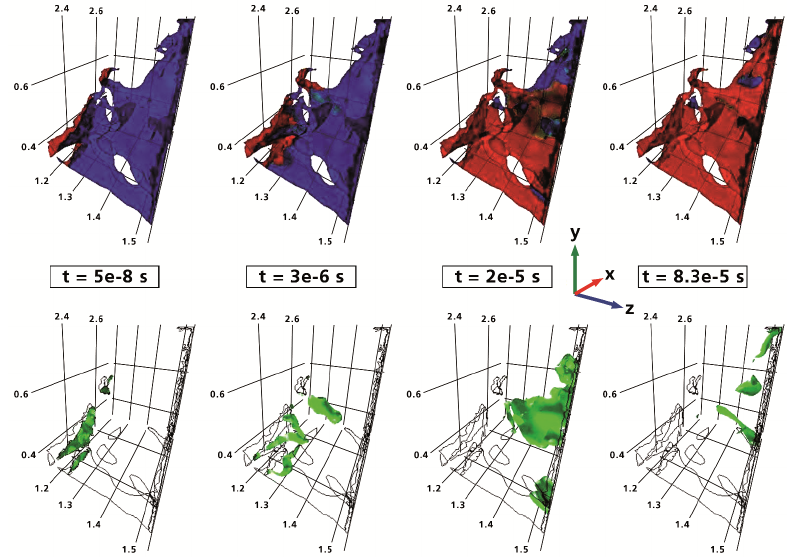
Figure 10. Image series showing the propagation of supercritical CO 2 displacing H 2 O (above) as well as the corresponding propagation of the fluid–fluid interface (below) at p c = 15 e 6Pa. The series is given for selected time steps within the µ -CT-based pore network geometry. Blue, red and green colours represent H 2 O, CO 2 phase and the fluid–fluid interface respectively. Grid values are given in